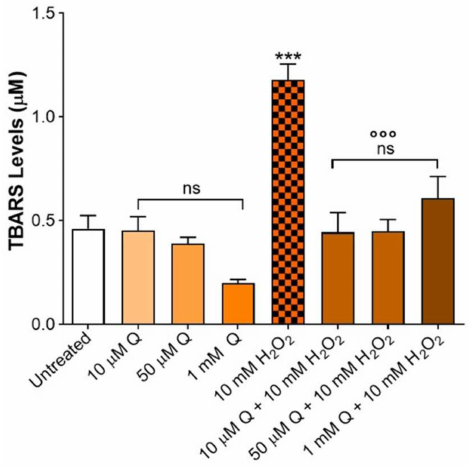
Figure 2. TBARS levels measured in erythrocytes left untreated or after treatment with increasing concentrations (10 µ M, 50 µ M, or 1 mM) of Q or 10 mM H 2 O 2 (positive control) with or without pre-incubation with Q. ns, not statistically significant versus untreated (control); ***, p < 0.001 versus control; ◦◦◦ , p < 0.001 versus 10 mM H 2 O 2 , one-way ANOVA followed by Bonferroni’s post hoc test ( n =